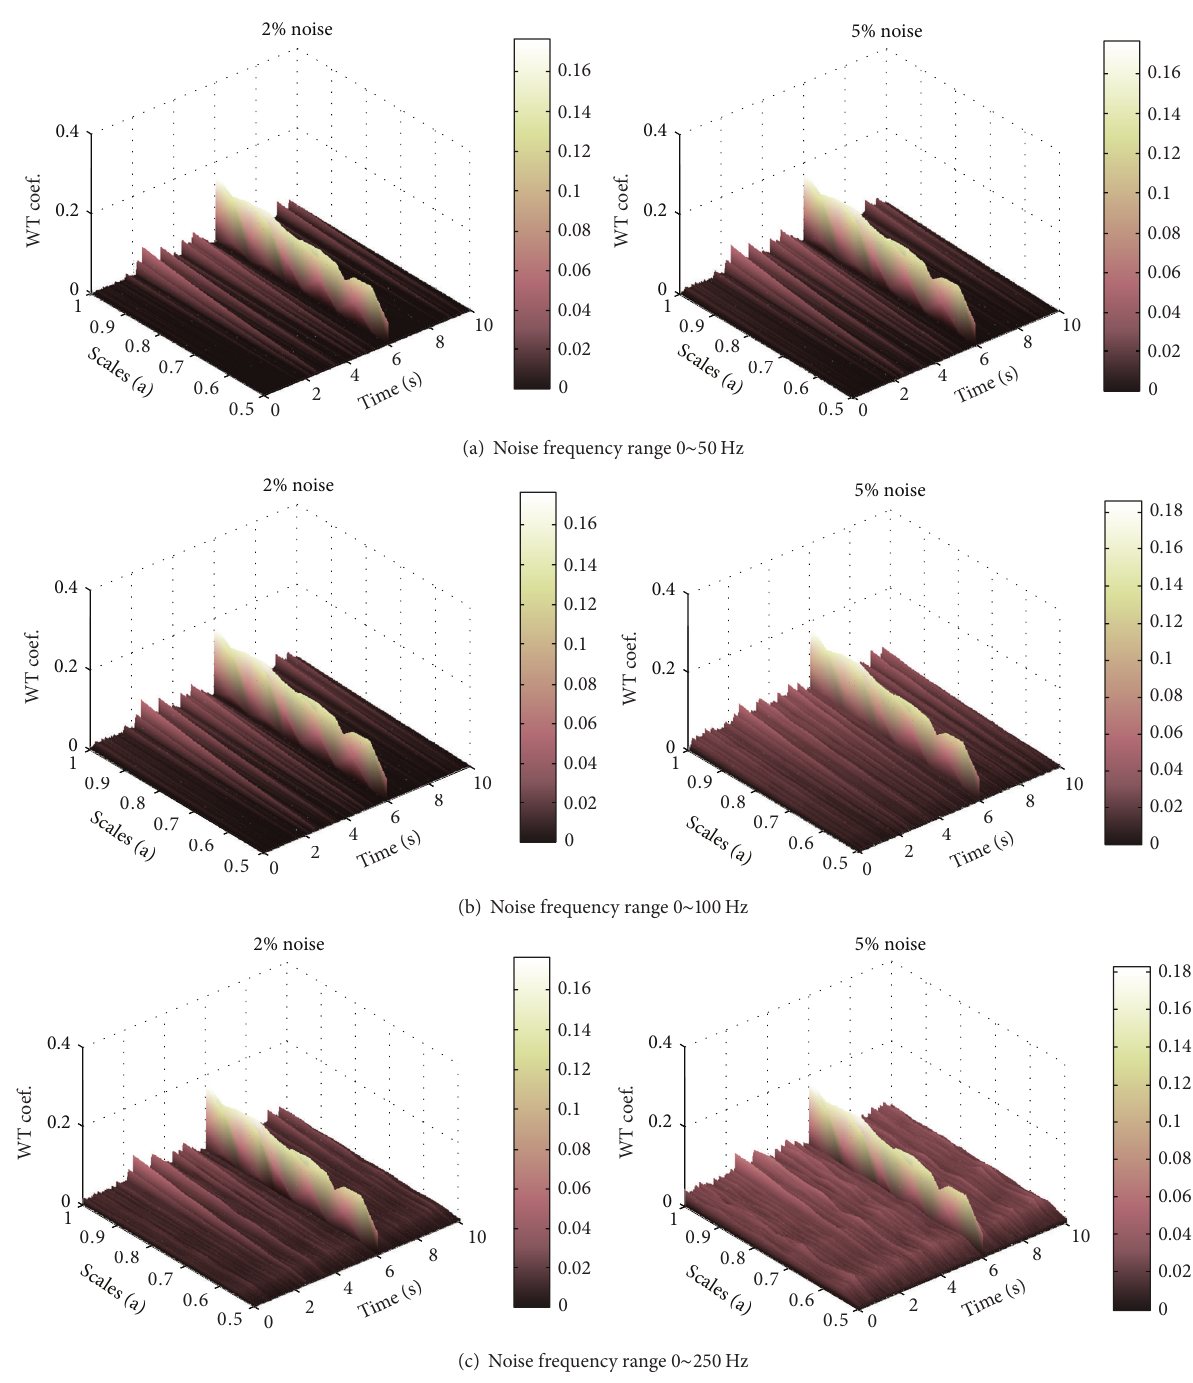
Figure 14: Detection results from contaminated acceleration responses (seismic